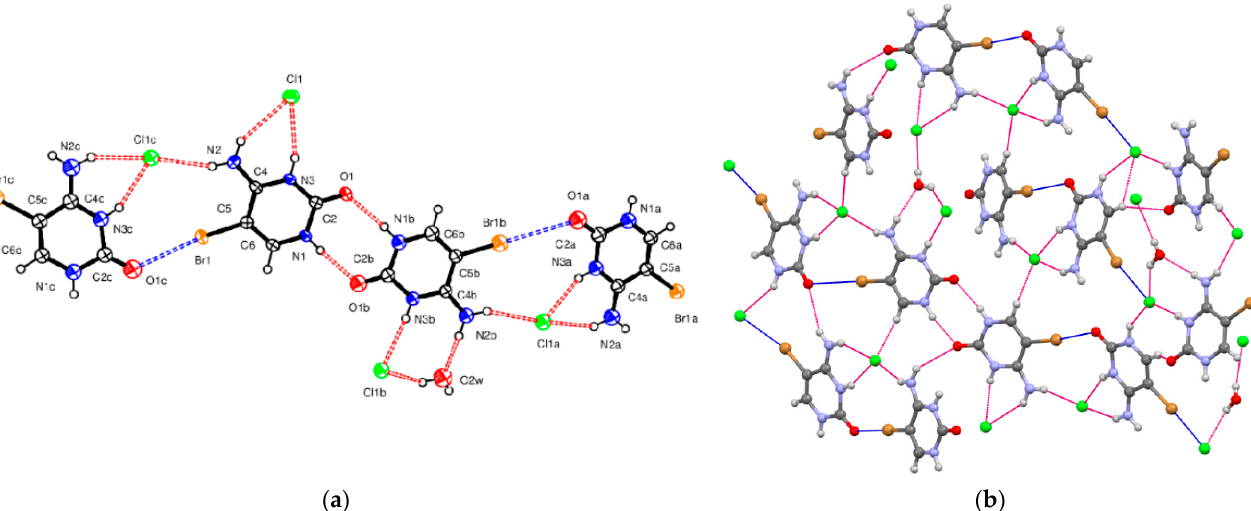
Figure 1. ( a ) The asymmetric unit of compound ( I ), showing the adopted atom-numbering scheme. Displacement ellipsoids are at the 50% probability level. H atoms are shown as small spheres of arbitrary radii. Hydrogen bonding is shown as red dashed lines. Halogen bonding is shown as blue dashed lines. ( b ) Part of the crystal structure of ( I ). All atoms are shown as small spheres of arbitrary radii. Hydrogen bonding is shown as red dashed lines. Halogen bonding is shown as blue dashed lines.